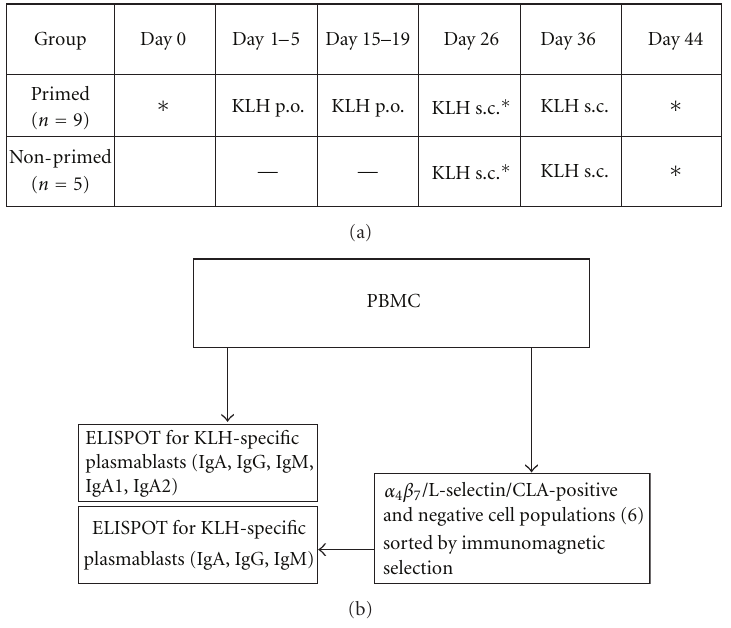
Figure 1: Experimental design of the study. (a) Protocol for immunization with KLH and for collection of blood samples. The asterisks indicate days of collecting blood samples. (b) Assaying KLH-specific circulating plasmablasts from the blood samples. The cells were assayed both from the total population of PBMC and from receptor-positive and -negative populations (a total of six separated populations for each volunteer) resulting from immunomagnetic sorting with respect to di ff erent